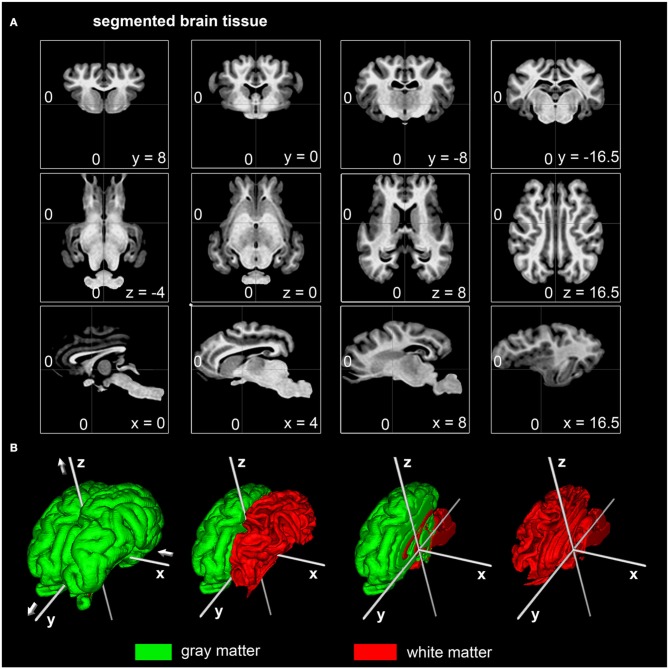
Stereotaxic coordinates of the segmented ovine population-averaged template. (A) The dorsal border of the anterior commissure was the origin of the Cartesian coordinate system (0;0;0) with the posterior commissure in line (y-axis) at coordinates (0;-16.5;0). All coordinates are given in millimeters. (B) Illustrations of the surface reconstruction for gray and white matter with the applied stereotaxic coordinate system (white): Values of the x-axis increase from left (negative) to right (positive) while the y-axis increase from caudal (negative) to rostral (positive). Values of the z-axis rise from ventral (negative) to dorsal (positive).